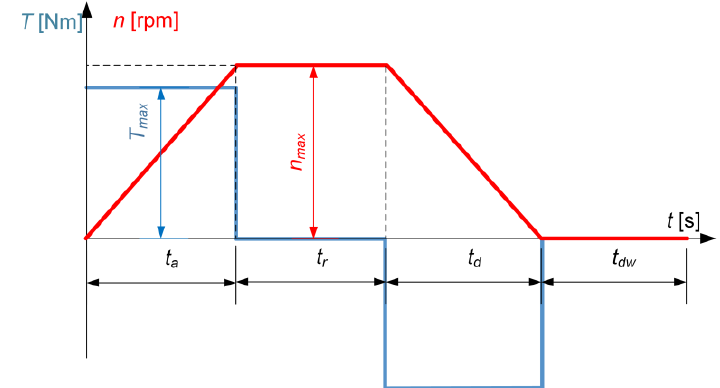
Figure 22. The profile of changes in the set speed and the torque of the jib rotation drive. The waveforms of speed, mechanical moment and mechanical power recorded on the shaft of the tested motor are shown in Figure 23. A summary of mechanical and electrical measurements of the average results during operation at the cycle is given in Table 6. Table 6 also contains the e ff ective results of recorded supplying values the drive unit’s converter. The results showed the power unit e ffi ciency of